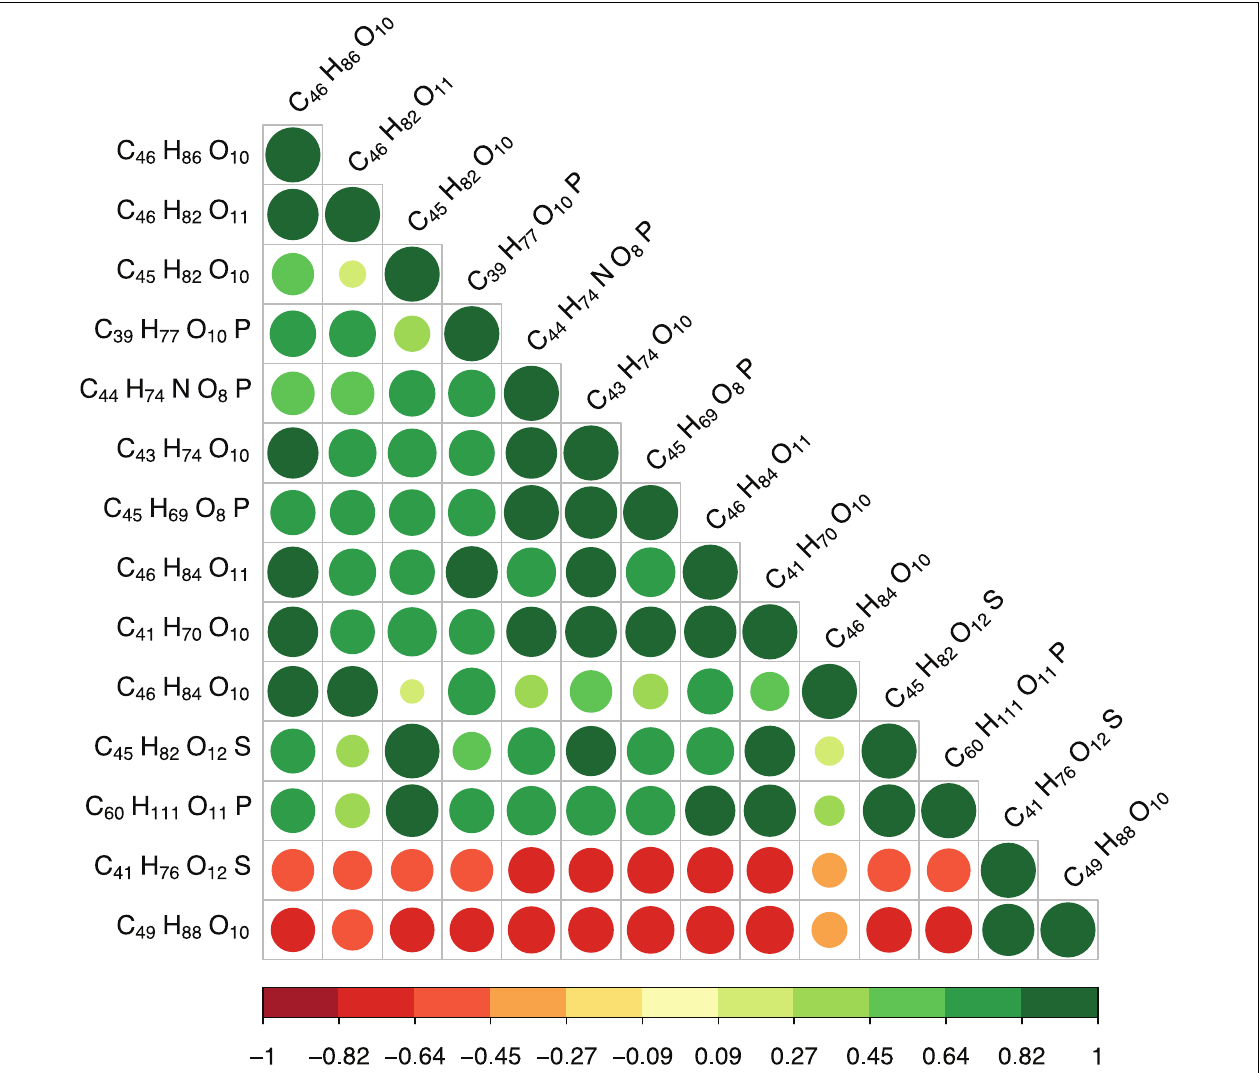
FIGURE 3 | Pearson correlations between differential metabolites (top 20). The size of the circle represents the magnitude of correlation. Green circles indicate positive correlations, red negative correlations. The value of the correlation coefficient ( r ) is shown in the color bar below the